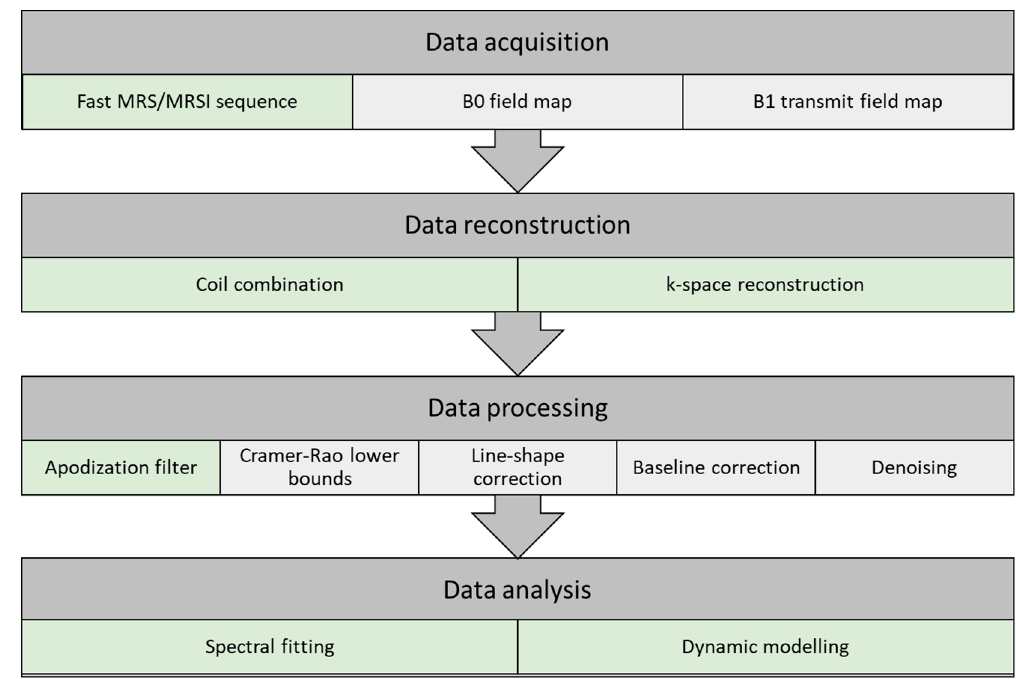
Figure 3. Flow chart of a pipeline for data acquisition, reconstruction, processing, and analysis of hyperpolarized carbon-13 MR spectra. The pipeline illustrates the conventional approach (light green) and suggestions for extended steps (light grey).